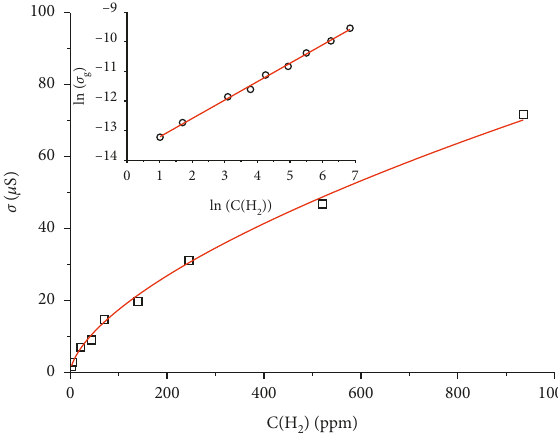
Figure 7: Dependence of conductivity for 0.24wt.% Pd/SnO based sensor versus H 2 concentration in air ambient in linear and logarithmic scales (inset).